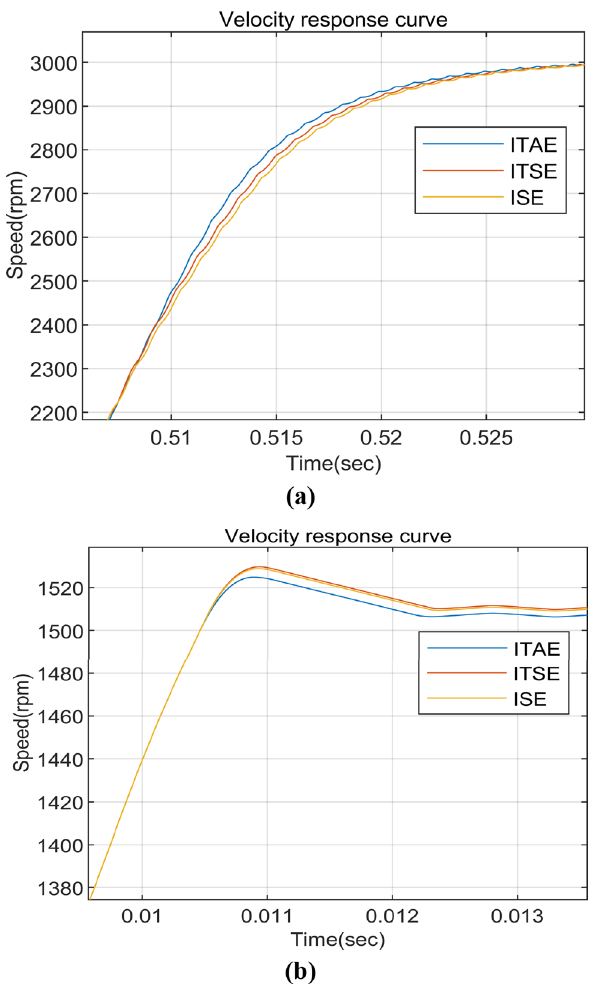
Fig. 11 P-PI controller optimal a scale factor and b fitness